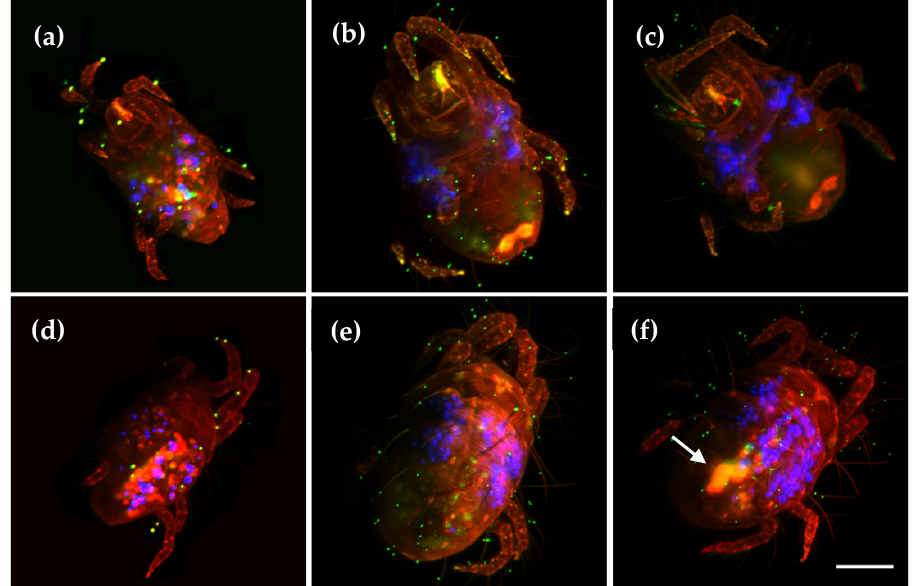
Figure 4. Maximum intensity projections from three different adult individuals of the spider mite species Tetranychus urticae . Two views are displayed: ( a – c ) ventral; ( d – f ) dorsal. The sexual dimor- phisms can be observed between males ( a , d ), and females ( b , c , e , f ). Levels of auto-fluorescence inside the mite also change between mated ( f ) and virgin females ( e ) (see arrow). Images obtained using a 16x objective and three laser lines for illumination: 488 nm (red), 567 nm (green) and 647 nm (blue). Volume reconstructions can be found in Video S3. Scale bar: 100 µm.